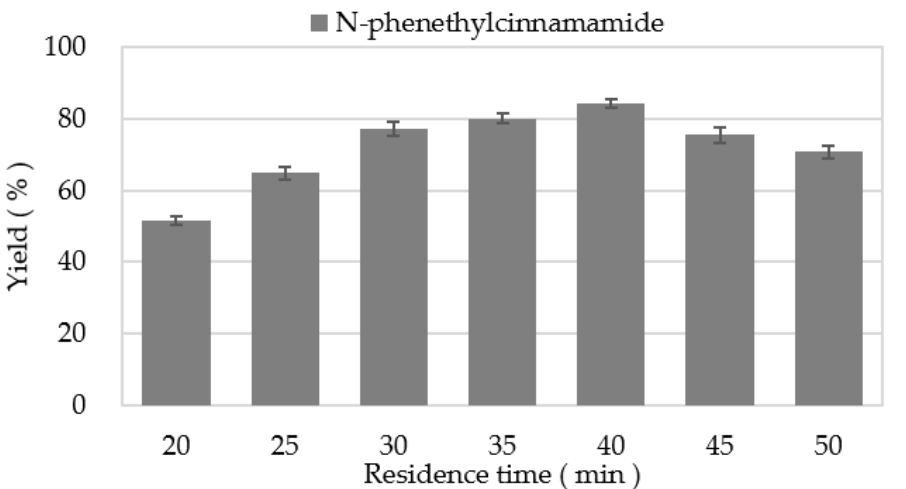
Figure 4. The effect of residence time on the synthesis of N-phenethylcinnamamide catalyzed by Lipozyme ® TL IM in continuous-flow microreactors.